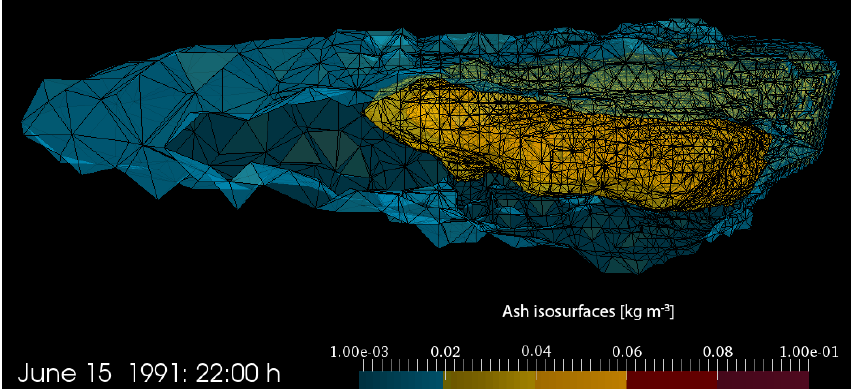
Figure 2. Triangulated mesh on the surface of the ash cloud. The ash cloud is represented on 15 June at 22:00 in a side view (from south). The concentration on the isosurfaces of the ash cloud is displayed in kgm − 3 . The minimum displayed ash concentration is 0.001kgm − 3 .